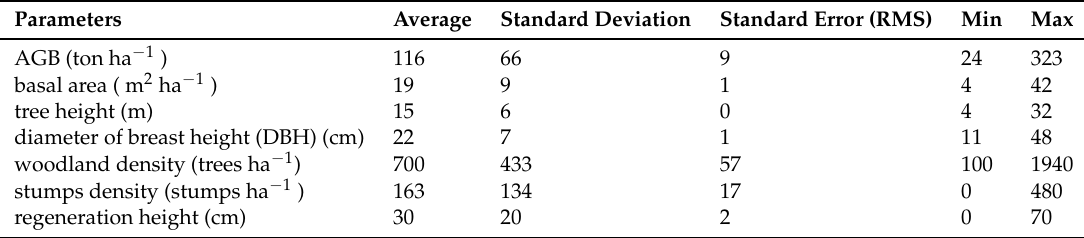
Table 3. Descriptive statistics of the variables sampled in the field ( n = 52).